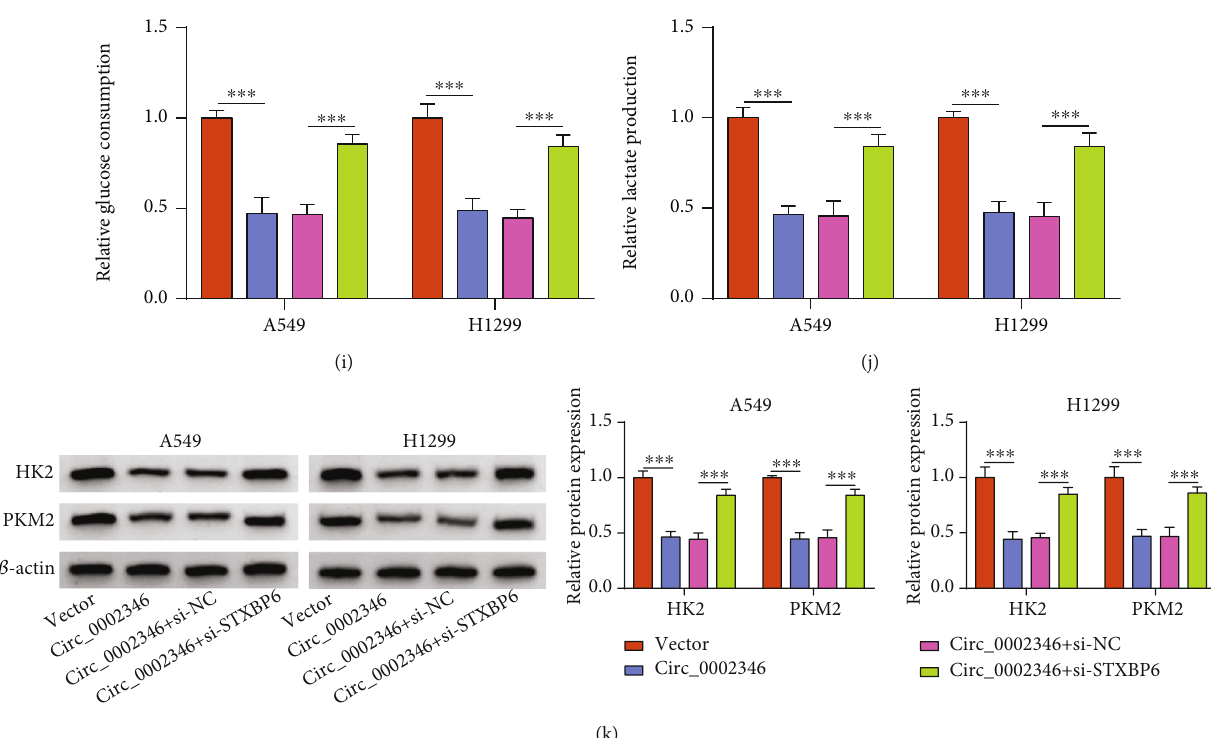
Figure 6: STXBP6 silencing partly o ff sets circ_0002346 overexpression-induced e ff ects in NSCLC cells. (a) A Western blot assay was conducted to measure the protein expression of STXBP6 in NSCLC cells transfected with si-NC or si-STXBP6. (b – k) A549 and H1299 cells were transfected with circ_0002346 alone or together with si-STXBP6. (b and c) An EDU assay and a colony formation assay were performed to measure cell proliferation ability. (d, e) Transwell assays were conducted to analyze cell migration and invasion abilities. (f) The apoptosis rate of NSCLC cells (FITC + and PI +/- ) was analyzed by fl ow cytometry. (g) The activity of caspase3 was analyzed using a caspase3 activity assay kit. (h) The protein levels of Bax and C-casp3 were measured by a Western blot assay. (i, j) The uptake of glucose and the production of lactate were measured using a fl uorescence-based glucose/lactate assay kit. (k) The protein expression of HK2 and PKM2 was examined in NSCLC cells by a Western blot assay. ∗∗ P < 0 : 01 ; ∗∗∗ P < 0 : 001